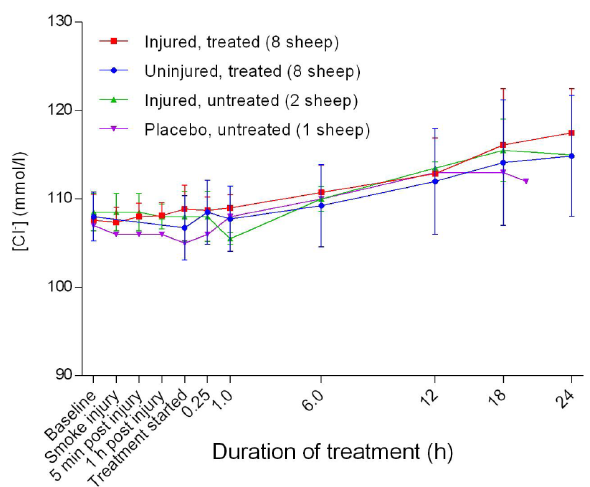
Figure 15. Concentration of chloride ions in blood (Mean ± SD) in smoke and non-smoke injured sheep that received extracorporeal life support as compared to that in untreated controls.